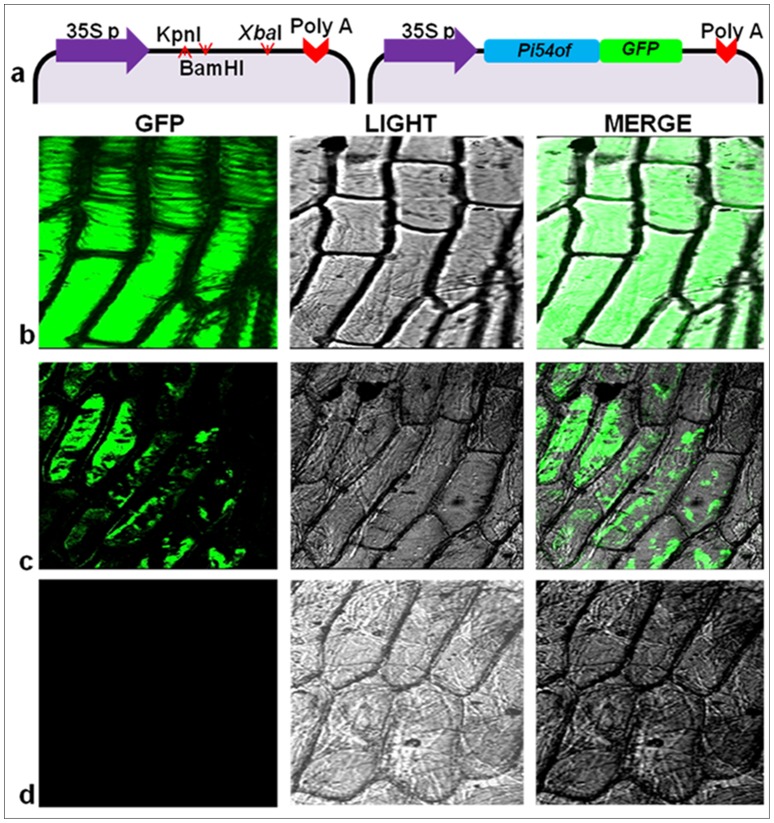
Sub-cellular localization analysis of Pi54of protein.Panel a: Schematic representation of construct used. Panel b: GFP alone under the control of CaMV 35S promoter; Panel c: GFP-Pi54of fusion protein under the control of CaMV 35S; Panel d- non bombarded onion cells.